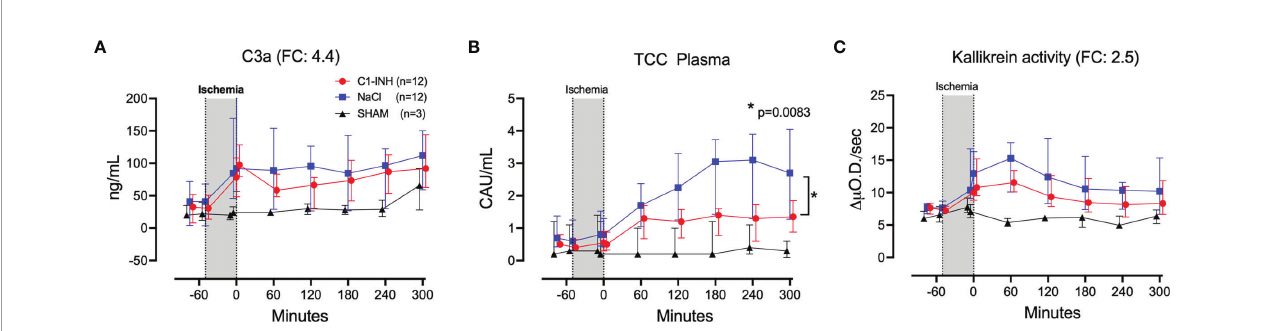
FIGURE 4 | Complement and kallikrein activation. (A) C3a, (B) terminal C5b-9 complement complex (TCC), and (C) kallikrein activity were measured in plasma of 24 piglets undergoing clamping of the thoracic aorta at the Th8 level. Upfront 12 piglets received human saline intravenously and 12 received C1-INH (250 IU/kg), respectively. Three sham animals received thoracic opening without clamping. Reperfusion started at 0 minutes and lasted 5 hours. Longitudinal time data are expressed as median and interquartile range. “ Ischemia ” indicates the 45 minutes period of clamping. NaCl and C1-INH-groups were combined when there were no differences in the fold change (FC) calculation. FC is the change from before cross-clamp onset to maximum change. * meaning: Probability of randomly seeing such a difference after C1-inhibitor